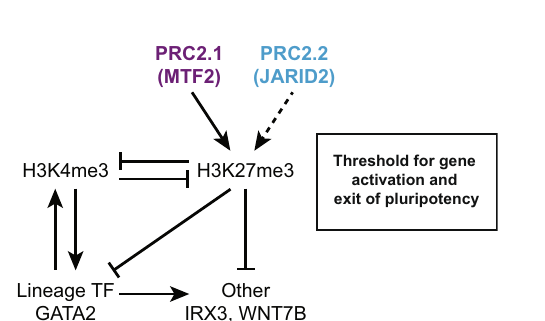
Fig. 7 Balance of transcriptional activation and exit of pluripotency tilted upon loss of PRC2.1/2.2. Model of the role of PRC2 in the exit of pluripotency. PRC2 contributes to a repressive threshold for activation of key regulators of differentiation. This affects the exit of pluripotency and the differentiation to lineages of the three germ layers. One example is the upregulation of GATA2 upon MTF2 loss which results in increasing expression of other factors such as WNT7B and IRX3, as part of a feedforward loop that regulates the exit of